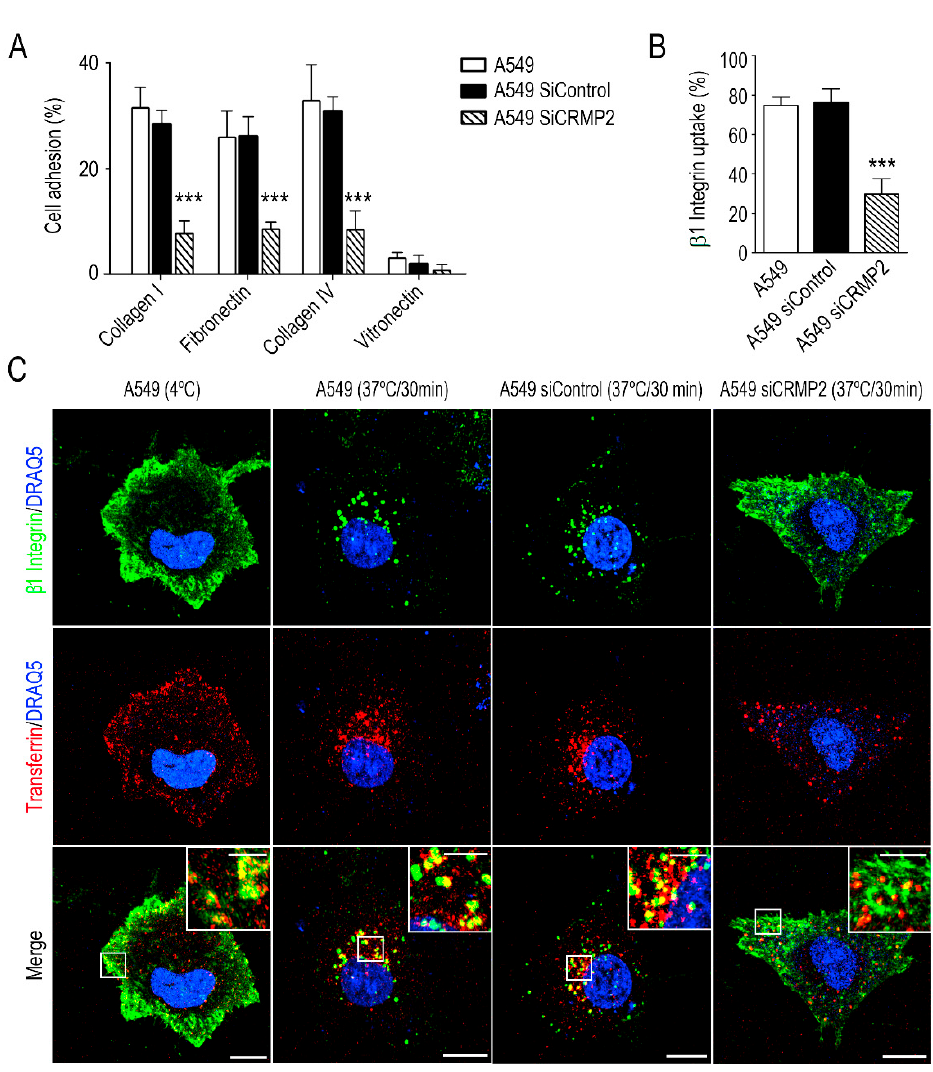
Figure 2. CRMP2 participates in cell adhesion and integrin β 1 recycling. ( A ) Cell adhesion of A549 cells transfected with CRMP2-specific or non-target siRNA sequences (25 μ M) to collagen I (50 μ g/mL), collagen IV (50 μ g/mL), fibronectin (10 μ g/mL) and vitronectin (1 μ g/mL) coated substrates. Data are shown as the percentage of cell adhesion relative to BSA. (n = 12); ( B ) quantification of β 1 integrin uptake by flow cytometry in the different cell lines analyzed. Data are shown as the percentage of internalized β 1 integrin relative to membrane expression at 4 °C. (n = 3); ( C ) representative maximum intensity projections confocal images of A549 cells stained with β 1 integrin (green), transferrin (red), and DRAQ5 (blue). Integrin uptake was stimulated for 30 min at 37 °C in serum-free media. Vesicle internalization was blocked at 4 °C. Scale bar = 15 microns. White insets show magnified areas with strong integrin β 1 and transferrin co-localization. Scale bar = 5 microns. *** ( p < 0.001).